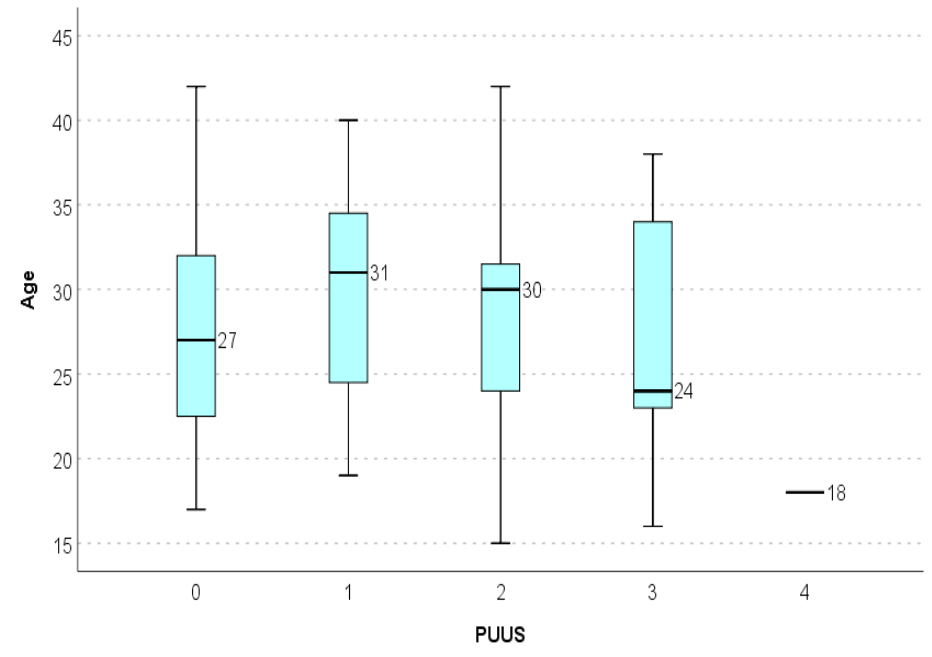
Figure 6. PUUS grade varied with age. ( p = 0.51).